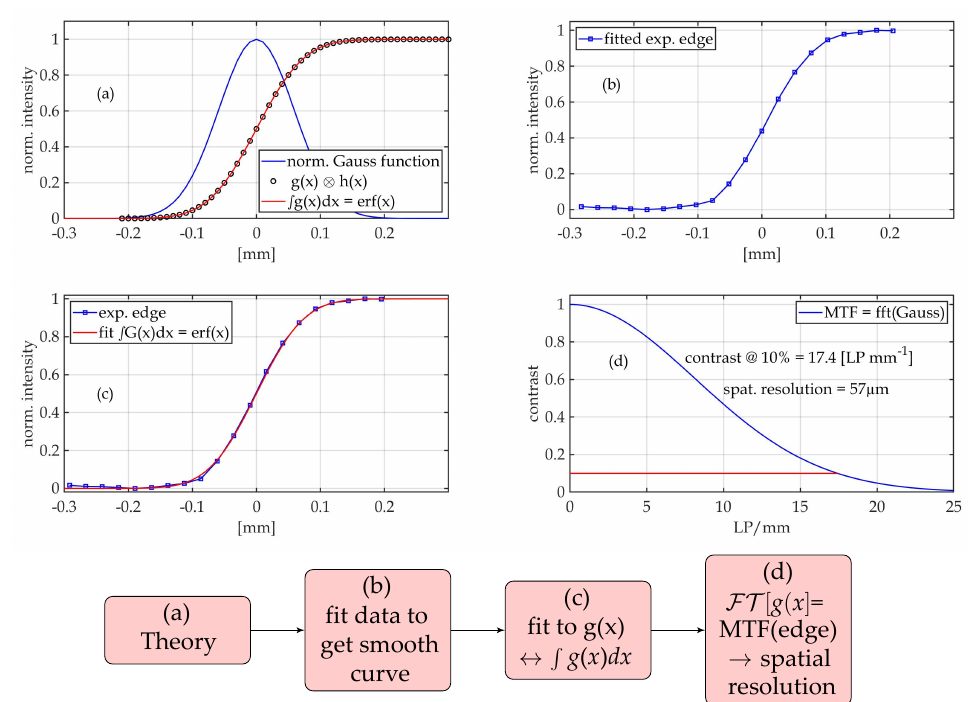
Figure 9. Fitting procedure and evaluation of the spatial resolution. The spatial resolution can be directly read from the 10% contrast at 17.4 LP/mm (appr. 57 µ m). 17.4 LP/mm are the maximum frequency f max that appears in the image with 10% contrast.